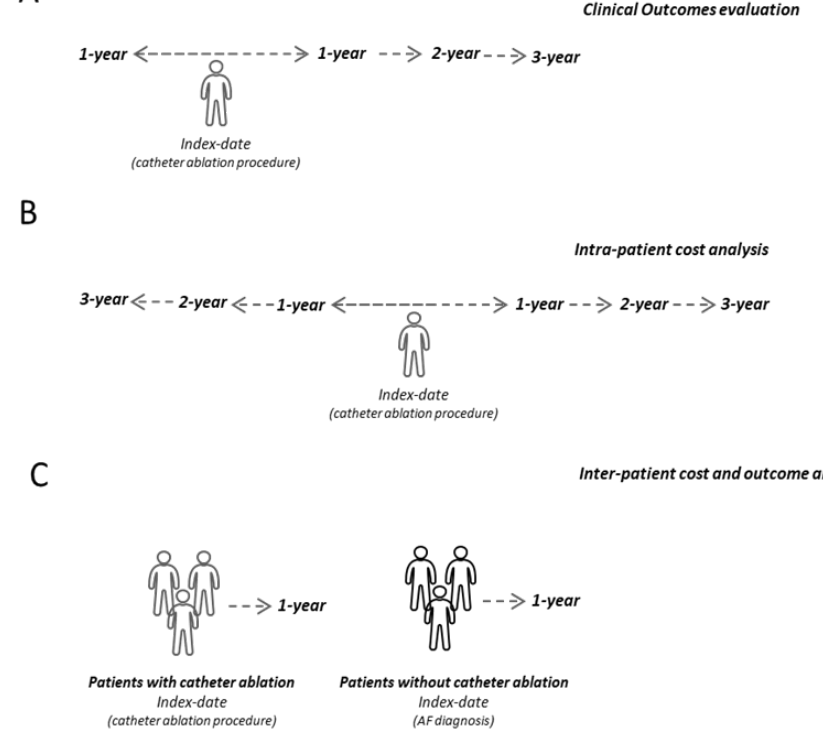
Figure 1. Schematic representation of the study design for clinical outcome evaluation ( A ), intra- patient cost analysis ( B ) and inter-patient cost and outcome analysis ( C ).